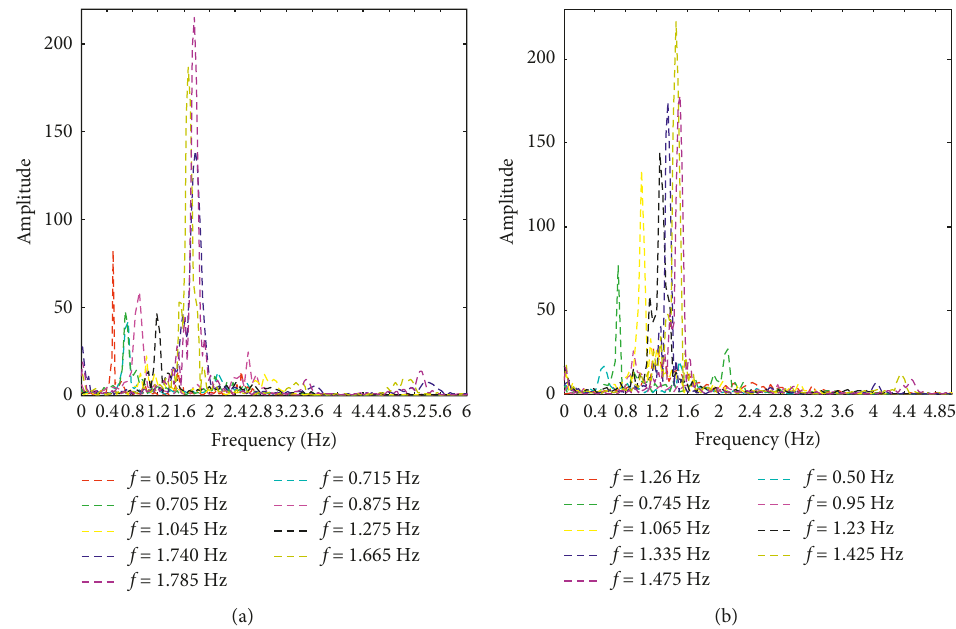
Figure 15: The structural response frequencies with crowds swaying. (a) Standing crowd swaying and (b) seated crowd swaying.